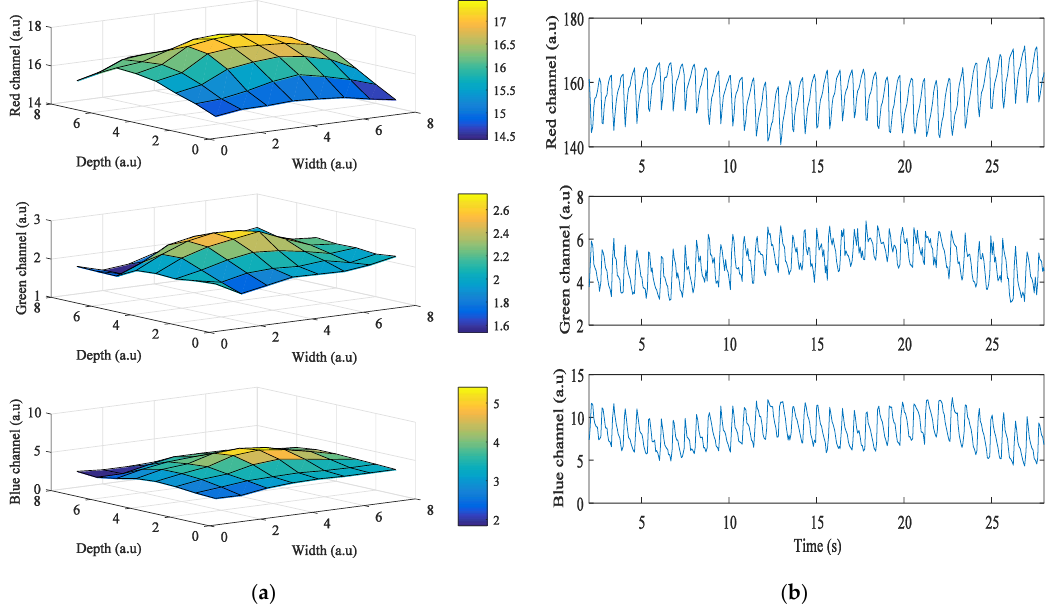
Figure 12. Example of quality analysis of PPG signals obtained from a subject using the Galaxy S6 with flash off: ( a ) intensity change distribution; ( b ) intensity of PPG signal.